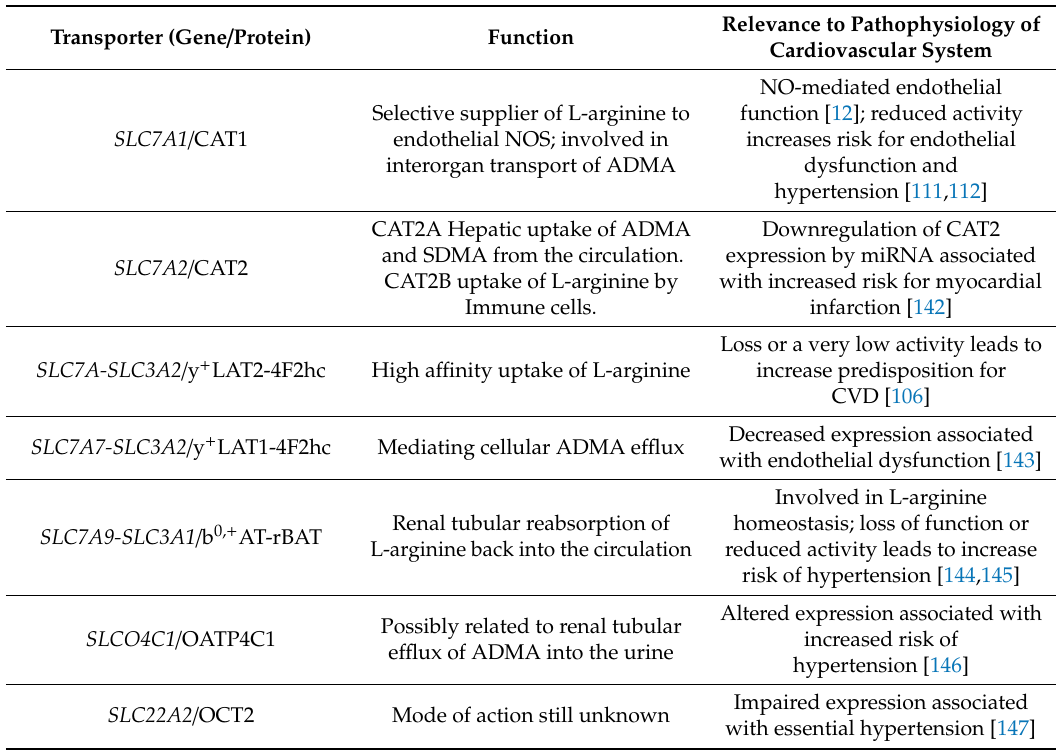
Table 4. Transporters of L-arginine and its derivatives involved in the pathophysiology of the cardiovascular